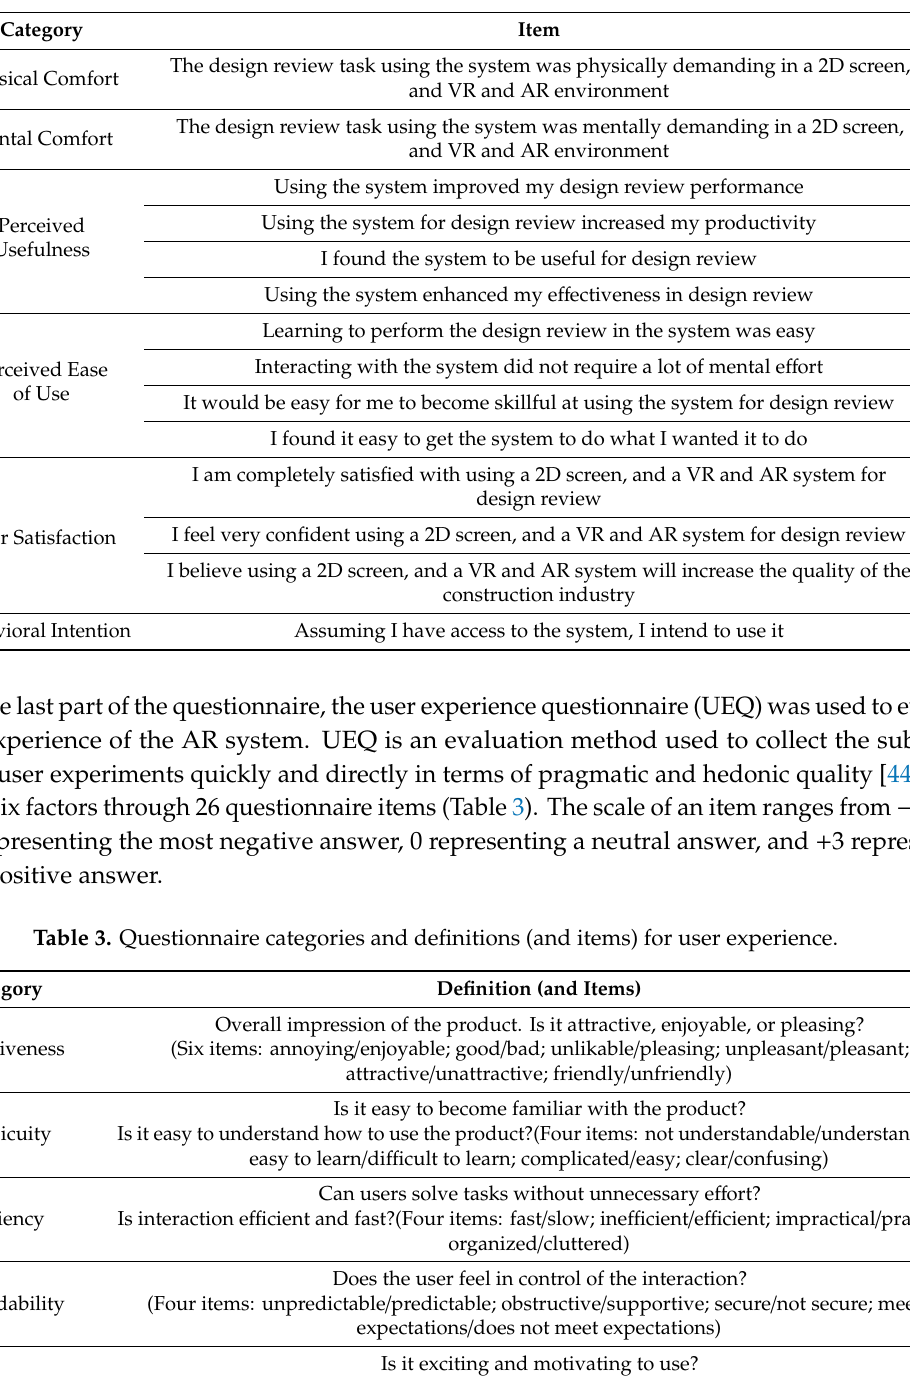
Table 2. Questionnaire categories and items for user acceptability.